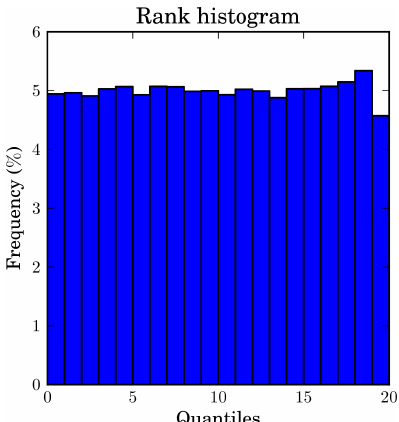
Figure 6. Rank histogram, also called Talagrand diagram, of prob- abilistic attenuation